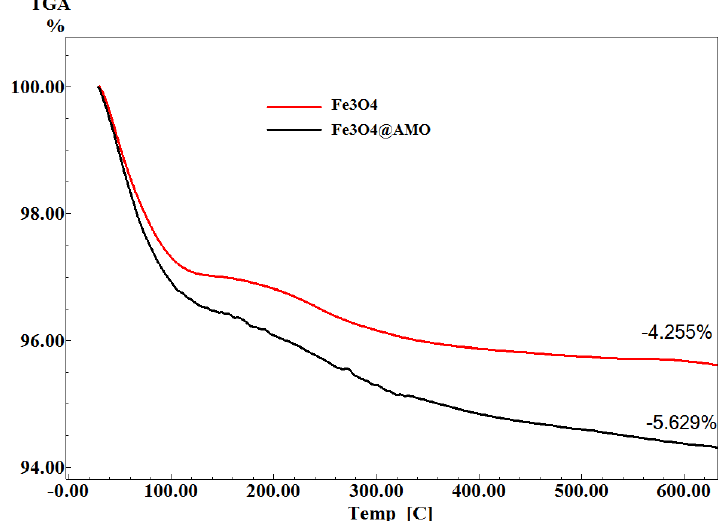
Figure 5. Flow cytometry results revealing the cell cycle progression of HCT8 cultured cells after the treatment for 24 h with the Fe culture (untreated), Fe Fe O @AMO = HCT8 cultures grown in the presence of 1 mg/mL Fe 3 4 based on One Way ANOVA